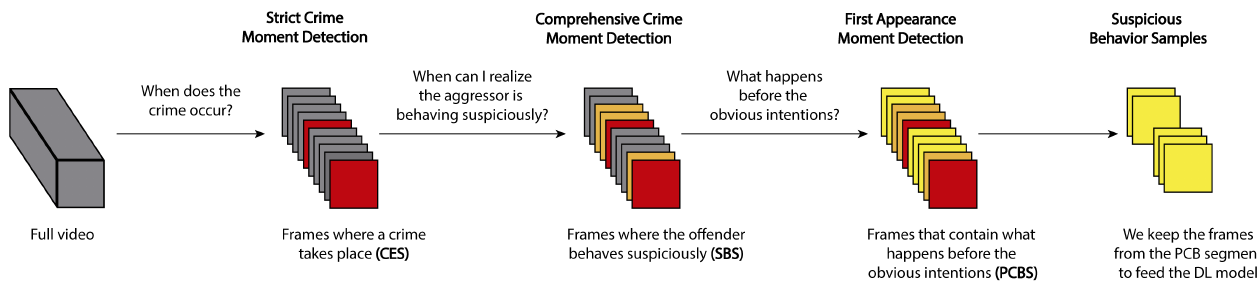
Figure 3. Graphical representation of the process for suspicious behavior sample extraction.